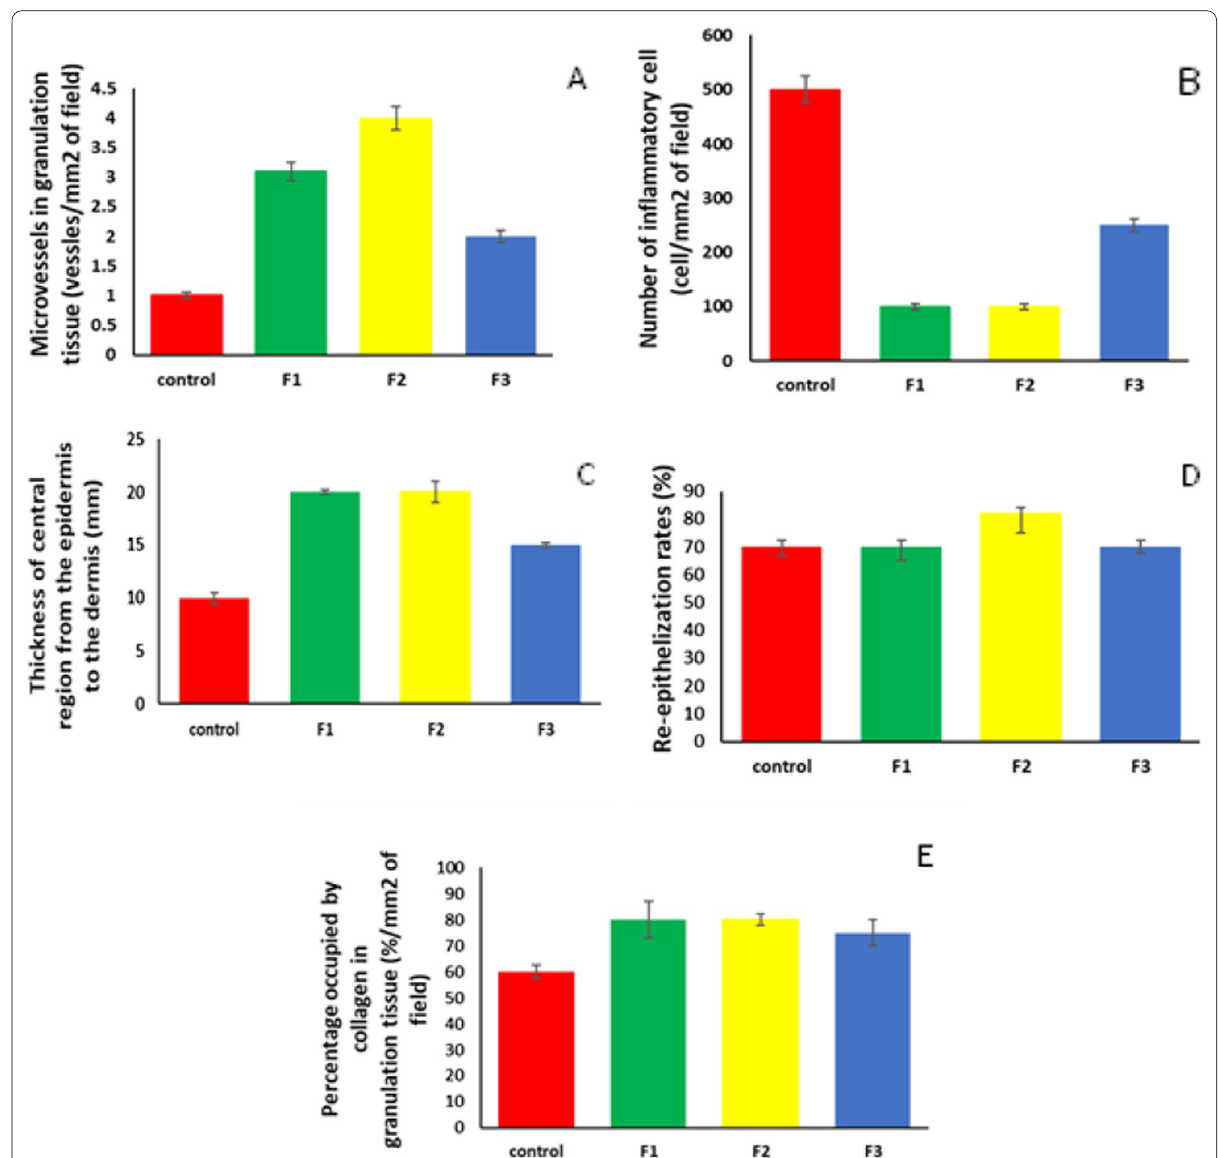
Fig. 6 Histomorphometrical values for surgical wounds showing the number microvessels in granulation tissue ( A ), number of inflammatory cells in the tissue percentage ( B ), thickness of the central region between the dermis and epidermis ( C ), re‑epithelization rates ( D ), percentage occupied by collagen in granulation tissue ( E